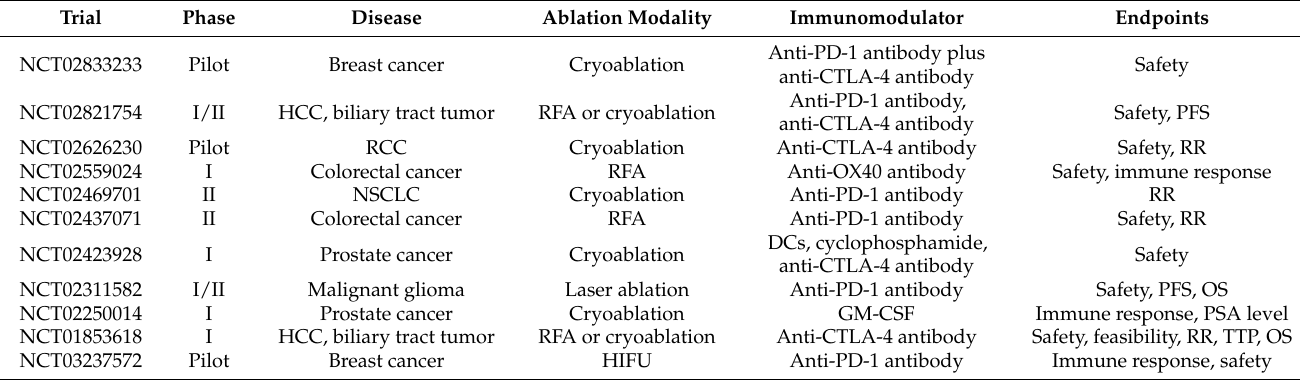
Table 1. Examples of ongoing clinical studies combining ablation with